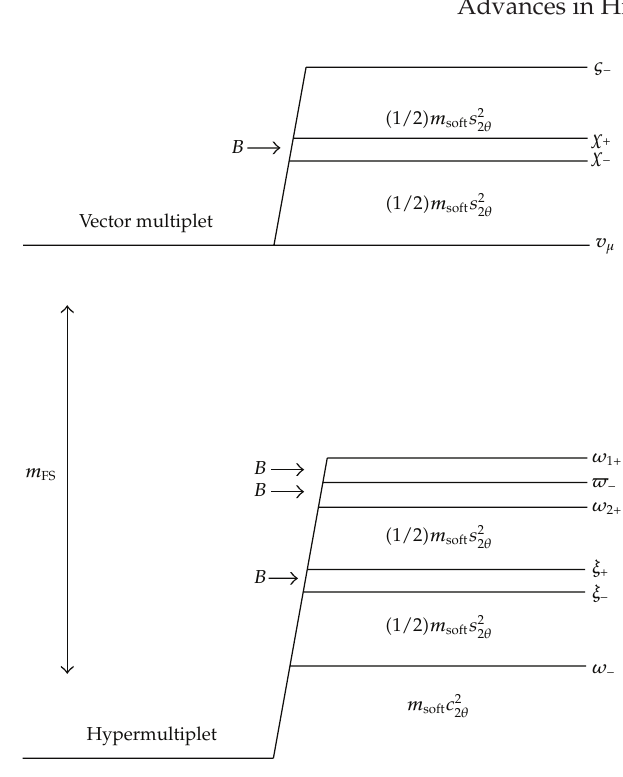
Figure 1: The ground state spectrum for the case m FS > 0 and in the limit that m FS (cid:15) m soft , where the mixing between the vector multiplet and hypermultiplet is small. The composition of the various states (cid:3) see (cid:3) 2.15 (cid:4) and (cid:3) 3.15 (cid:4)(cid:4) is a function of tan 2 θ (cid:7) m ω − is predominantly scalar-scalar, whereas in the opposite limit (cid:3) m e (cid:14) m p (cid:4) , ω − is predominantly fermion-